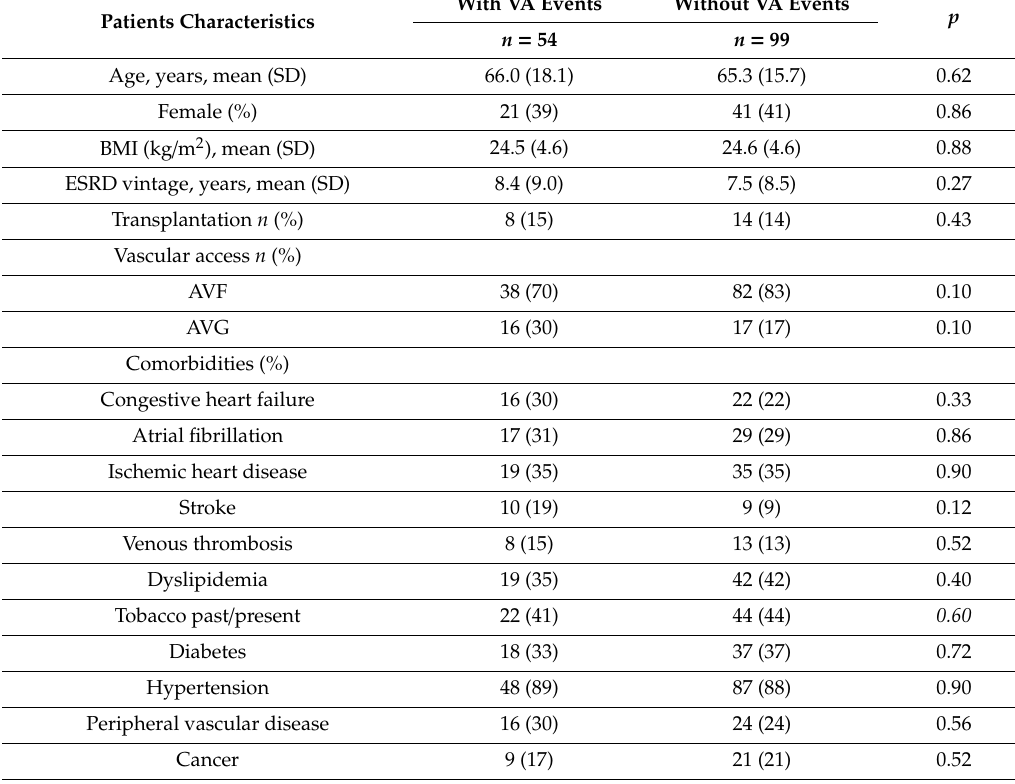
Table 2. Baseline characteristics of patient with vascular access events or not. Patients